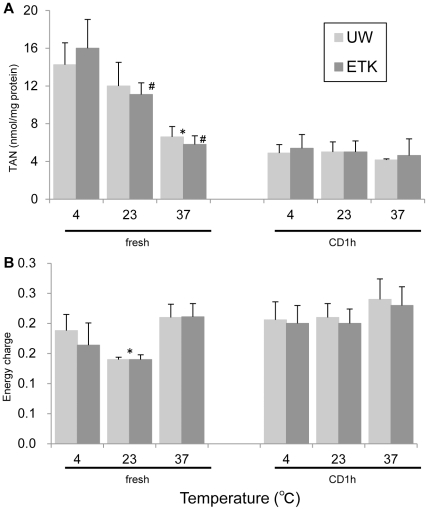
Impact of each preservation solution and temperature on tissue TAN and EC of preserved rat kidney.(A): The TAN of fresh kidneys at 37°C and CD1h at all temperatures were lower than that of fresh kidneys at 4°C and 23°C (* p<0.05, fresh37 vs. fresh4 in UW; # p<0.05, fresh37 vs. fresh4 and 23 in ETK). (B) The EC of the fresh37, CD1h4, CD1h23, and CD1h37 groups was not higher than that of the fresh4 and fresh23 groups. The EC of fresh23 with UW preservation was significantly lower than that of fresh4 (* p<0.05).